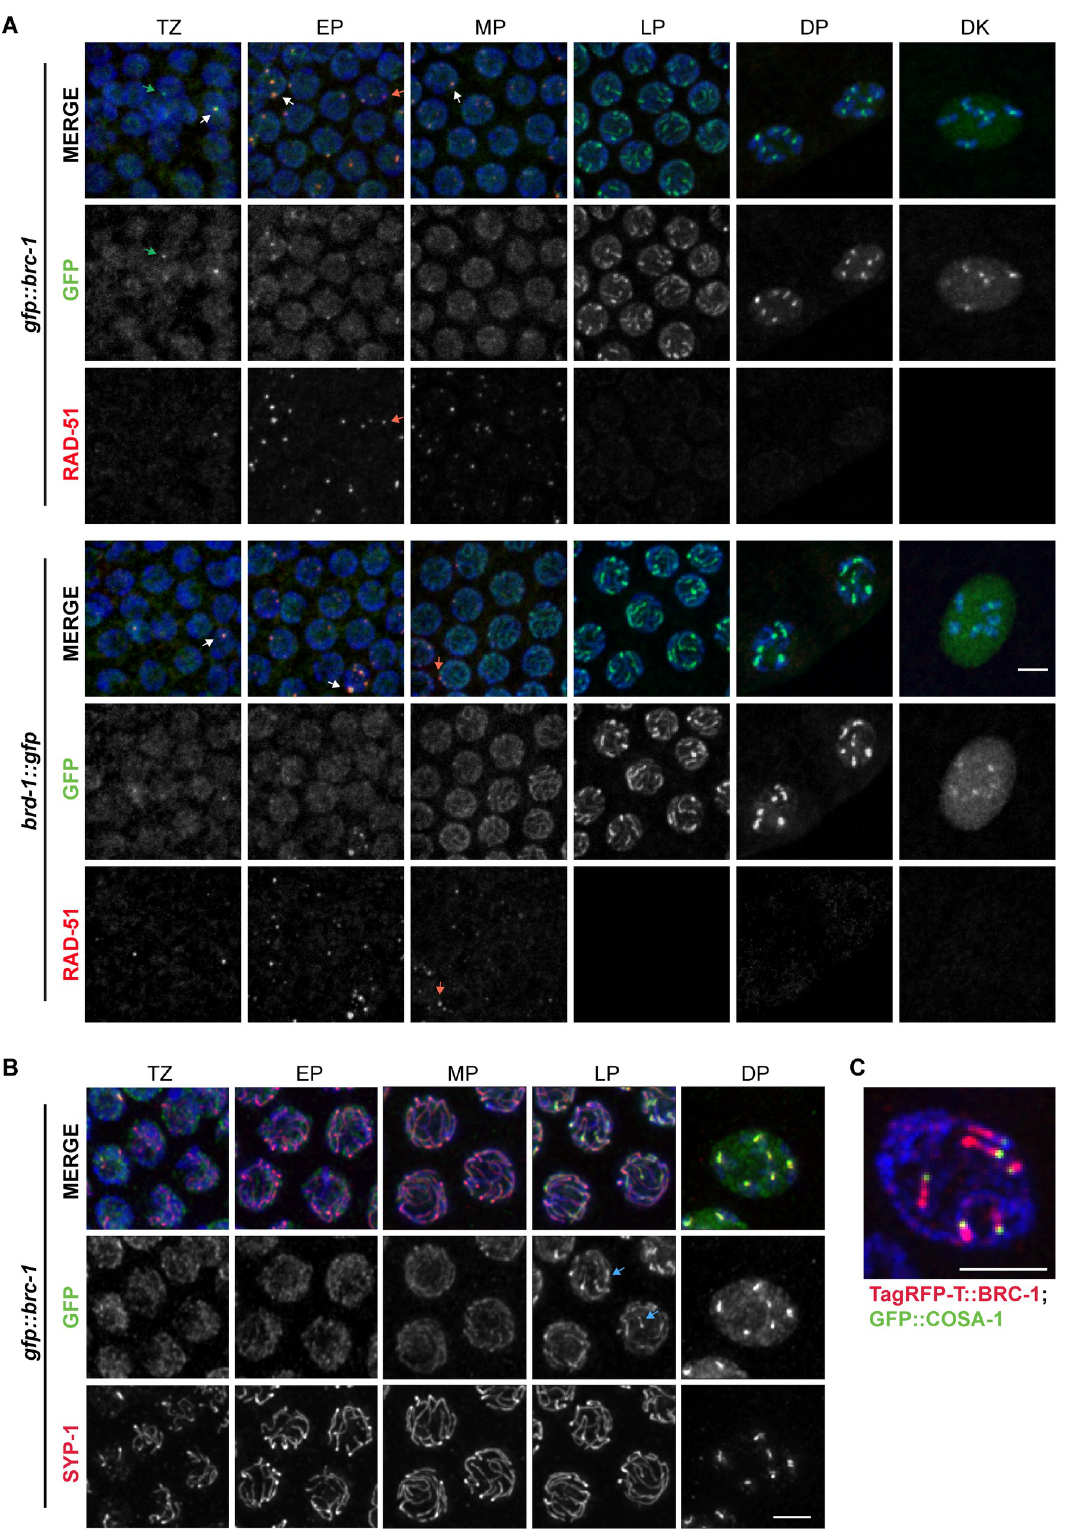
Fig 2. GFP::BRC-1 and BRD-1::GFP localize to the SC in meiotic prophase. A) Nuclei from indicated meiotic stages stained with RAD-51 antibodies (red), DAPI (blue) and imaged for GFP fluorescence (green). White arrows demark foci positive for both GFP